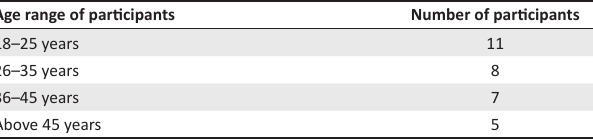
TABLE 1: Age range of